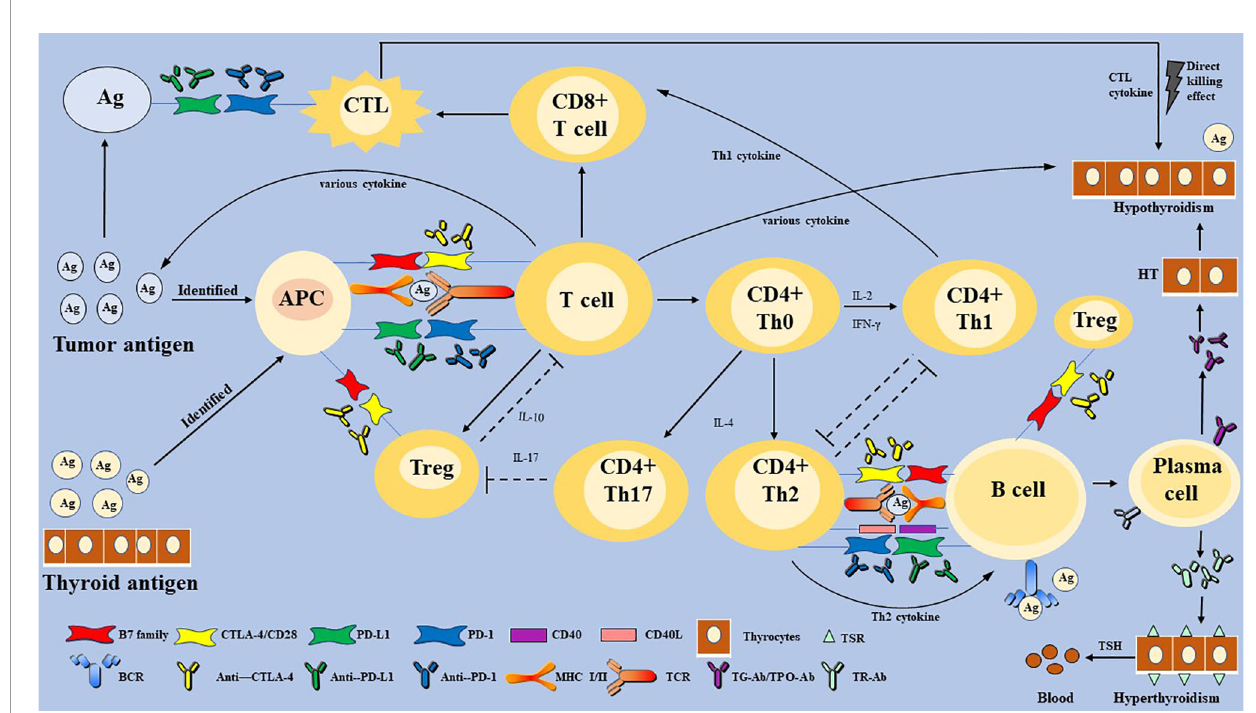
FIGURE 2 | The proposed mechanism of immune checkpoint inhibitors-related thyroid dysfunction. Thyroid IRAEs may involve T and B-lymphocytes, multiply cytokines, and diverse factors. Immune checkpoints are activated to escape the immune killing and clearance effect in most malignant tumor cells. Some immunotherapeutic agents can eliminate the inhibitory effect of T cells, which restore the anti-tumor response. However, activation of the immune system can also affect normal organ tissues, and lead to cell death, eventually leading to organ IRAEs. Thyroid IRAEs present mainly as hypothyroidism, hyperthyroidism, and transient thyroiditis, seem to overlap with AITDs. HT and GD are AITDs that cause hypothyroidism and hyperthyroidism, respectively. HT is caused by impaired immune tolerance of autoantigens, the destruction of thyroid cells. The pathogenesis of HT is considered to be a complex autoimmune process involving various activate and in fi ltrate T lymphocytes, B lymphocytes, and various cytokines. Then a cellular immune response and humoral immune response are induced, leading to direct thyroid injury and further thyroid antigen exposure. The main pathogenesis of GD can be understood as the combination of TSH receptor and TR-Ab secreted and released by Th2 cell-dependent B cells. Immune checkpoints are proposed to play a role in inhibiting the autoimmune process by inhibiting various immune cells. Whether thyroid IRAEs have the same mechanism as AITDs, warrants further elucidation. PD-1, programmed cell death gene-1; PD-L1, programmed cell death gene-1 ligand; CTLA-4, cytotoxic T-lymphocyte-associated antigen-4; MHC, major histocompatibility complex; Th cells, helper T cells; CTL, cytotoxic T lymphocyte cell; Treg, T-regulatory cells; APCs, antigen-presenting cells; TSH, thyroid-stimulating hormone; TPO-Ab, thyroperoxidase antibodies; TG-Ab, thyroglobulin antibody; TRAb, TSH receptor antibodies; AITDs, autoimmune thyroid diseases; HT, Hashimoto ’ s thyroiditis; GD, Graves ’